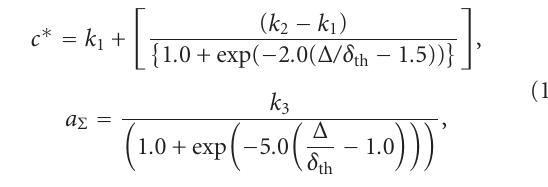
flow is fully resolved (i.e., Δ → 0) according to (10). It has been found that m = 1 . 85 enables (10) to capture the qualitative behaviour of C sg1 when the optimum values of c ∗ and a Σ are chosen. The optimum value of c ∗ ( a Σ ) tends to increase with decreasing (increasing) Δ . The κ m dependences of ( S r + S n ) and |∇ c | are reflected mostly in the resolved scale but these e ff ects weaken with increasing values of Δ [9, 11]. As the resolved and subgrid curvature terms are closely related [9, 11], the qualitative behaviour of C sg1 is also a ff ected by the κ m dependences of ( S r + S n ) and |∇ c | , which leads to the variation of the optimum values of a Σ and c ∗ . The model parameter β 4 is found to decrease with decreasing values of Σ gen for satisfactory quantitative prediction of C sg1 , which is accounted for by expressing β 4 as β 4 = 9 . 80 Σ gen × δ th . The prediction of (10) ensemble averaged on (cid:3) c isosurfaces is compared with the ensemble averaged values of C sg1 in Figure 5 for all cases for the optimum values of c ∗ and a Σ , for Δ = 0 . 8 δ th and Δ = 2 . 4 δ th , when β 4 and m are taken to be β 4 = 9 . 80 Σ gen × δ th and m = 1 . 85. The optimum values of c ∗ and a Σ are estimated by calibrating the prediction of (10) with respect to the values of C sg1 obtained from DNS data and the variation of the global mean optimum values of c